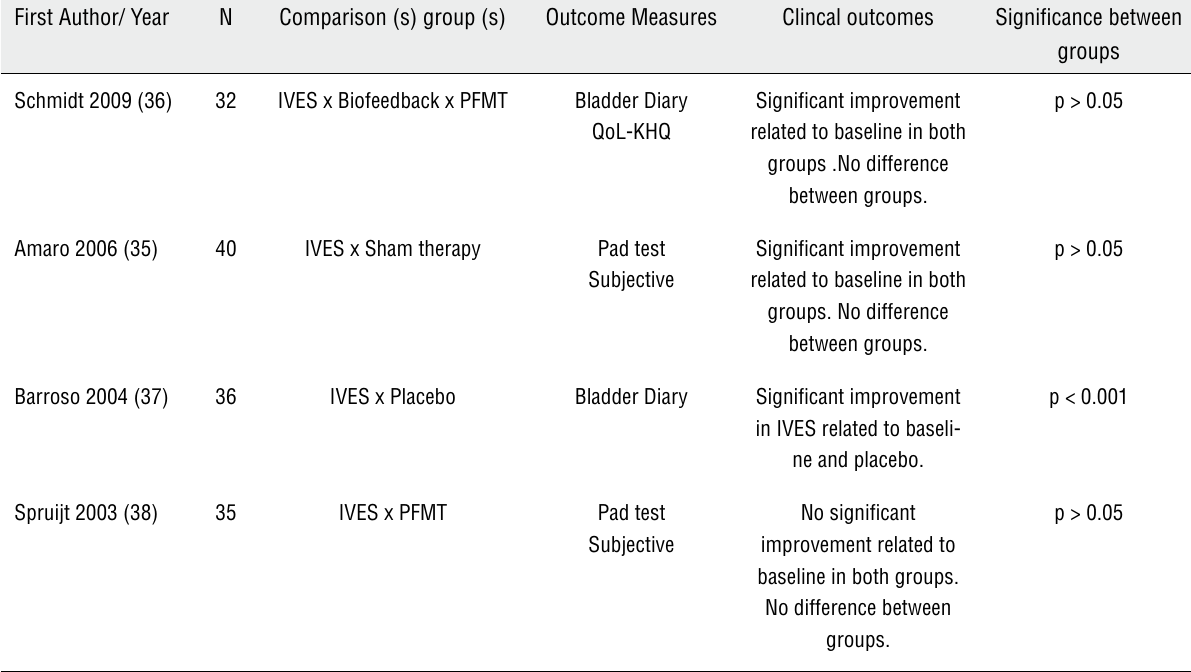
Table 3 - Outcome parameters of intravaginal stimulation in mixed urinary